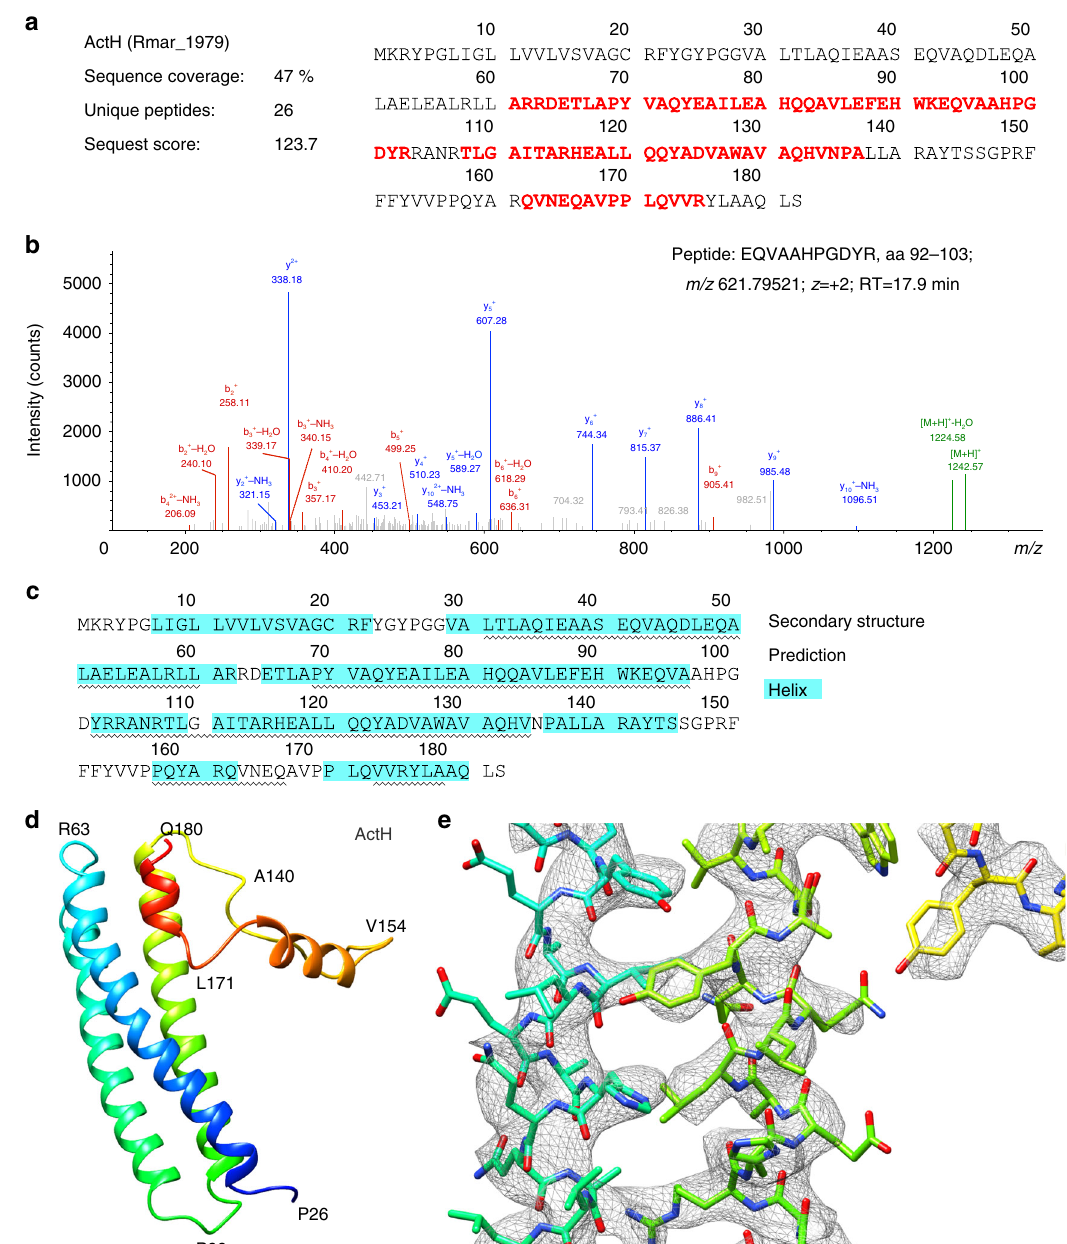
Fig. 3 Identi fi cation of ActH by mass spectrometry. a ActH (Rmar_1979, Uniprot identi fi er: D0MKF0) identi fi cation using LC – MS/MS (sequence coverage: 47%, matched peptides highlighted in red). b Annotated MS/MS spectrum for peptide EQVAAHPGDYR, corresponding to amino acid residues 92 – 103 of ActH. c Secondary structure predicted by PredictProtein with helices highlighted in cyan. Helices identi fi ed in the map are indicated by a wavy line. d ActH rainbow-colored from blue (N-terminus) to red (C-terminus). The N-terminal domain is a three-helix bundle, with helices of around 30 residues. The remaining 50 residues form a long loop located in the cleft between ActB, ActA, and ActE and two short helices. e Cryo-EM density map of ActH with model. Density is seen for most side chains, with the exception of glutamates and aspartates, which are highly radiation sensitive 16 –